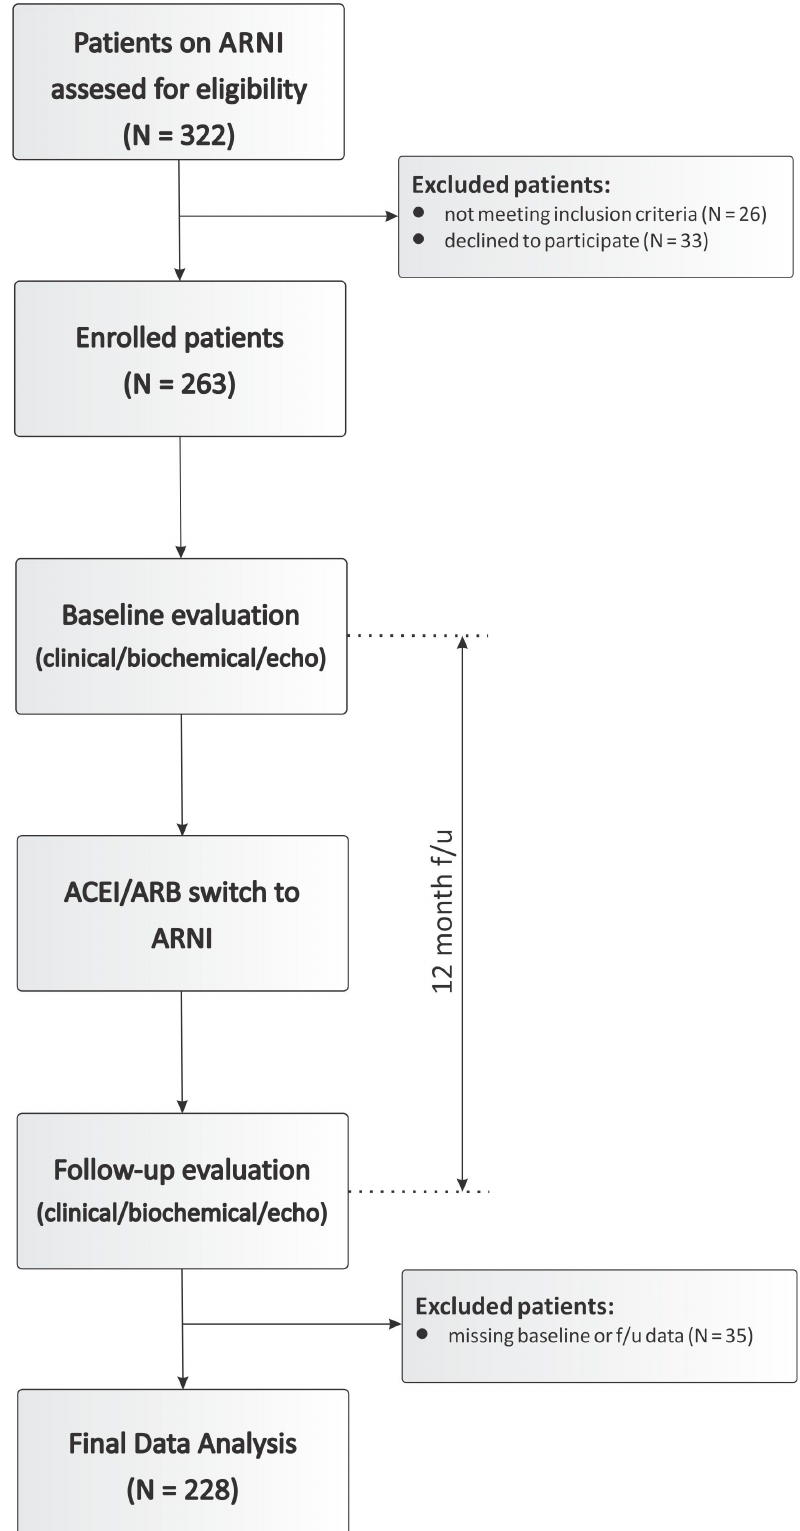
Figure 1. Study consort diagram.